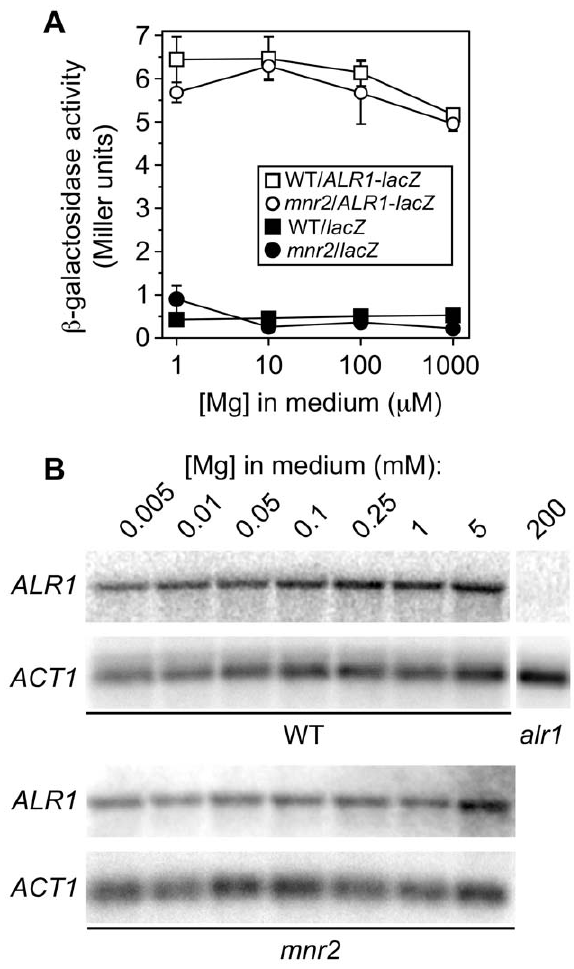
Figure 3. Effect of Mg supply and the mnr2 mutation on ALR1 gene expression. ( A ) WT (DY1457) and mnr2 (NP4) strains trans- formed with YEpALR1-lacZ ( ALR1-lacZ ) or control promoterless lacZ vector (YEp353, lacZ ) were grown to log phase in LMM with the indicated Mg concentration, and b -galactosidase activity determined. Error bars indicate + / 2 1 SEM (six replicates). ( B ) Effect of Mg supply and the mnr2 mutation on ALR1 mRNA accumulation. mRNA was purified from WT (DY1457) or mnr2 mutant (NP4) cultures grown to log phase in LMM containing the indicated Mg concentration and subjected to Northern analysis. Blots were probed with a 32 P-labeled PCR product of the ALR1 gene, stripped, and reprobed with a 32 P-labeled PCR product of the ACT1 gene. mRNA from an alr1 :: HIS3 mutant (NP10) grown in YPD + 200 mM Mg was included as a control for ALR1 probe specificity ( alr1